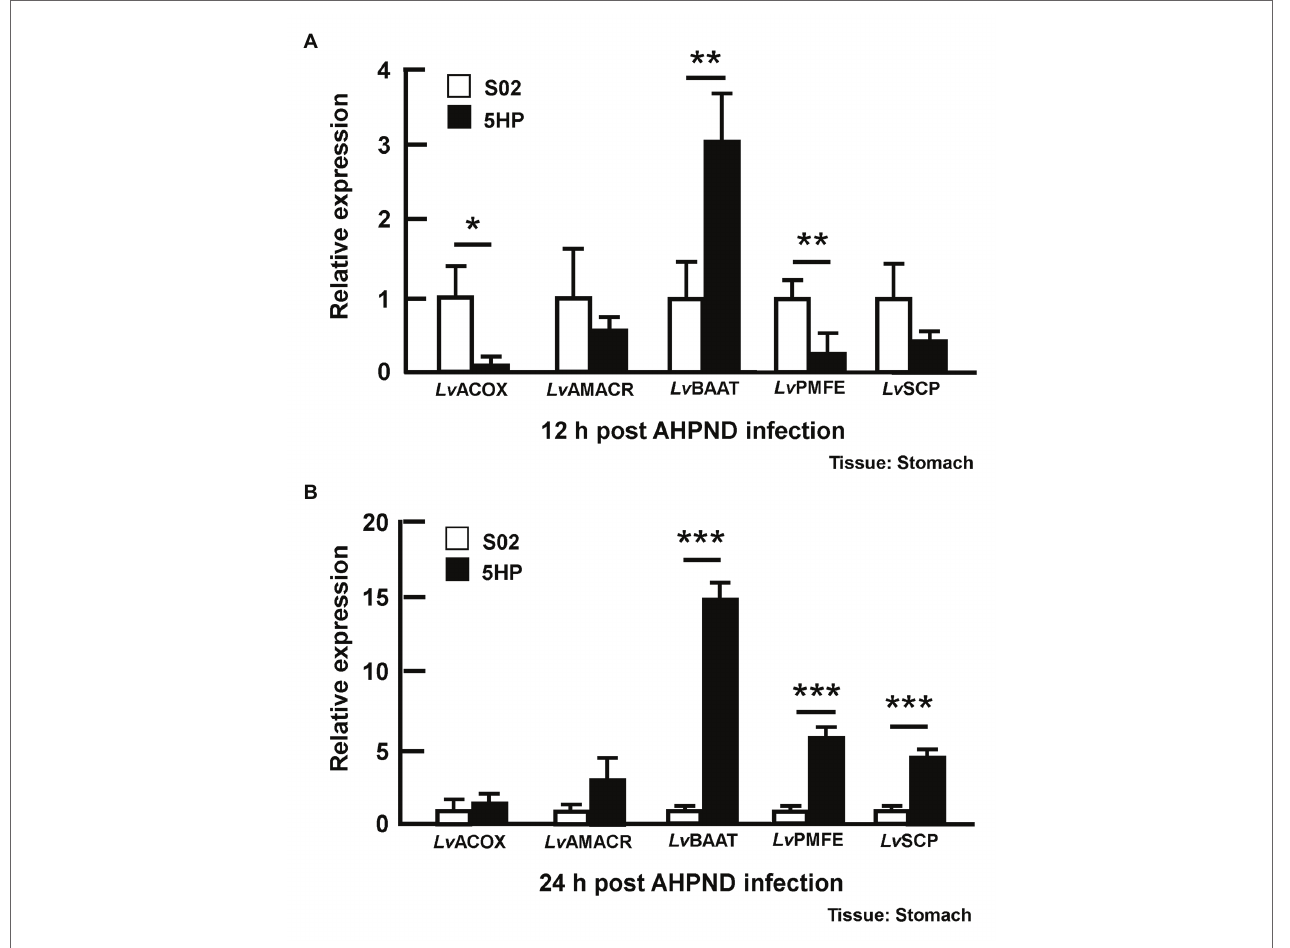
FIGURE 5 | Expression of bile acid synthesis genes was modulated during AHPND infection. Stomach samples collected at (A) 12 and (B) 24 hpi from shrimp challenged with either S02 or 5HP were used to analyze gene expression of bile acid synthesis related genes ( Lv ACOX, Lv AMACR, Lv BAAT, Lv PMFE, and Lv SCP). Data are mean ± SD. Differences between treatment groups are indicated by asterisks (Student’s t -test, * p < 0.05, ** p < 0.01, and *** p <